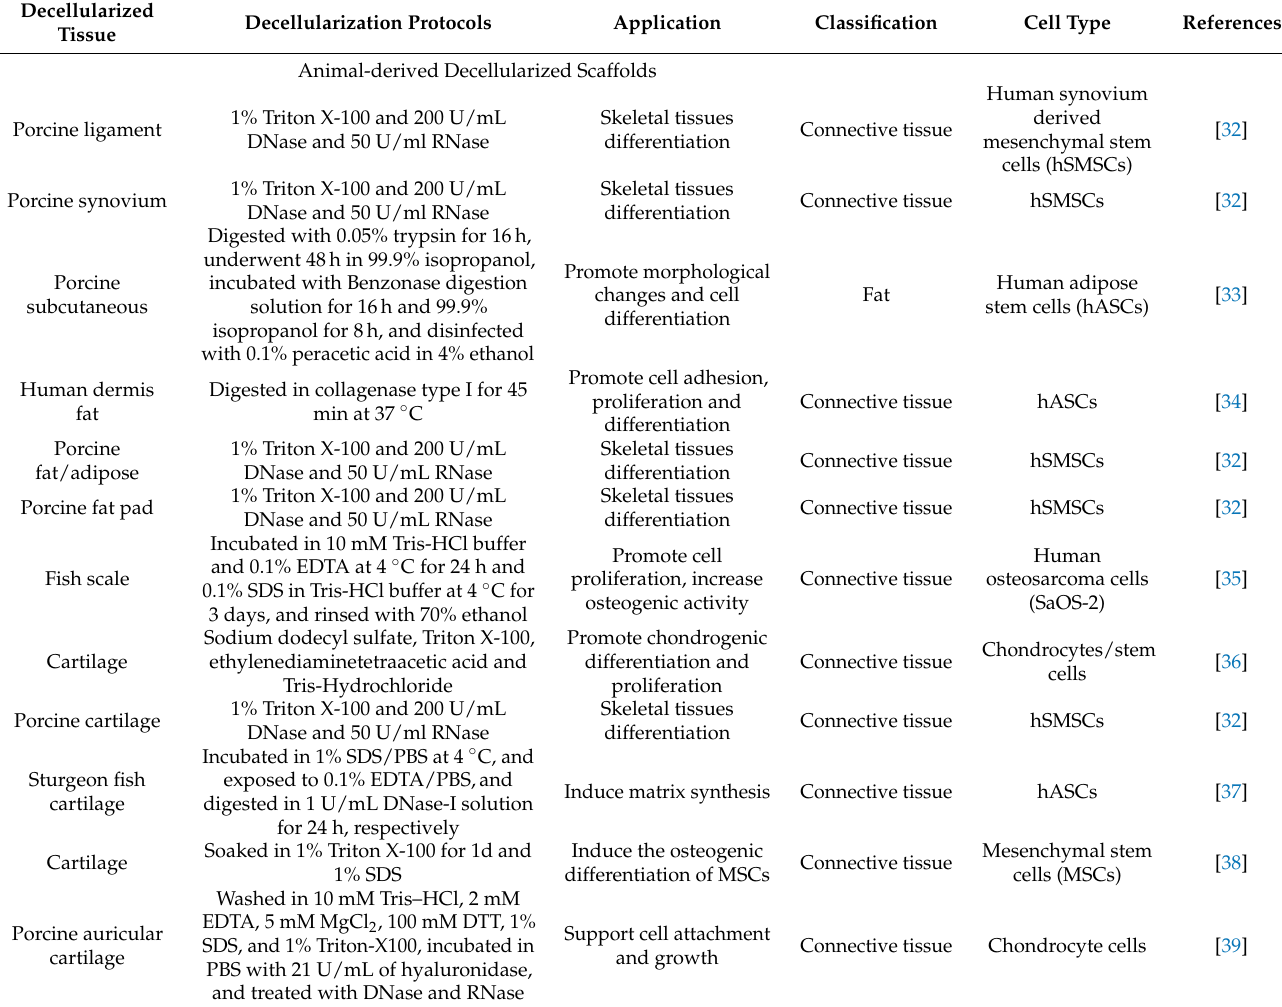
Table 1. Summary of applied studies on the decellularized scaffolds in the food